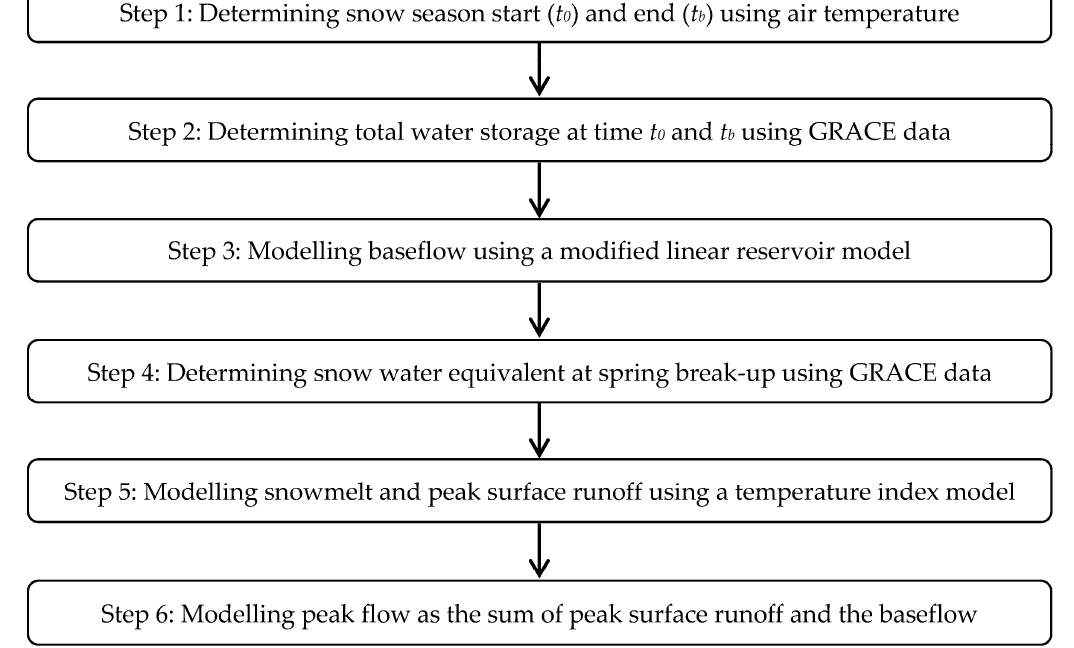
Figure 2. Flowchart for the modelling processes.